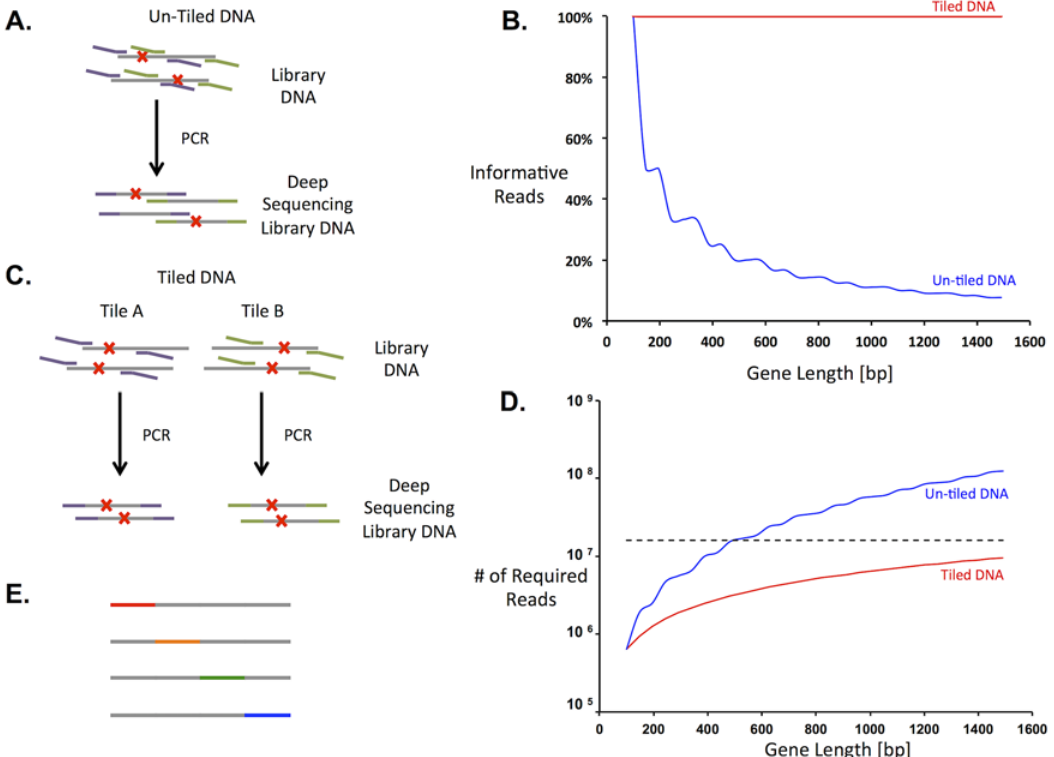
Fig 2. Gene tiling increased the efficiency of deep sequencing for sequence-function mapping. A . Deep sequencing without using gene tiles. Gene sequences are represented by grey lines, mutations by red x ’ s, and sequencing primers by purple and green lines. Several previous methods to amplify target DNA (left) amplify both mutated and non-mutated regions. The latter result in wasted reads and increase the sequencing capacity necessary to resolve the entire library. B . Percent of usable reads as a function of gene length with (red line) and without (blue line) gene tiling. C . Gene tiling has the ability to reduce the number of DNA sequencing reads necessary by targeting the region with a mutation in PCR amplification for sequencing purposes. To implement gene tiling, separate libraries are prepared and sorted for each tile. D . Number of sequence reads required for 300-fold average coverage of nonsynonymous mutations with (red line) or without (blue line) gene tiling. The horizontal dashed line represents the average number of DNA sequences from a single MiSeq lane. E . In gene tiling, short contiguous stretches of DNA (tiles) are targeted for mutations. Gene tiles are indicated by the colored dashed lines and cover the entire gene sequence among the different